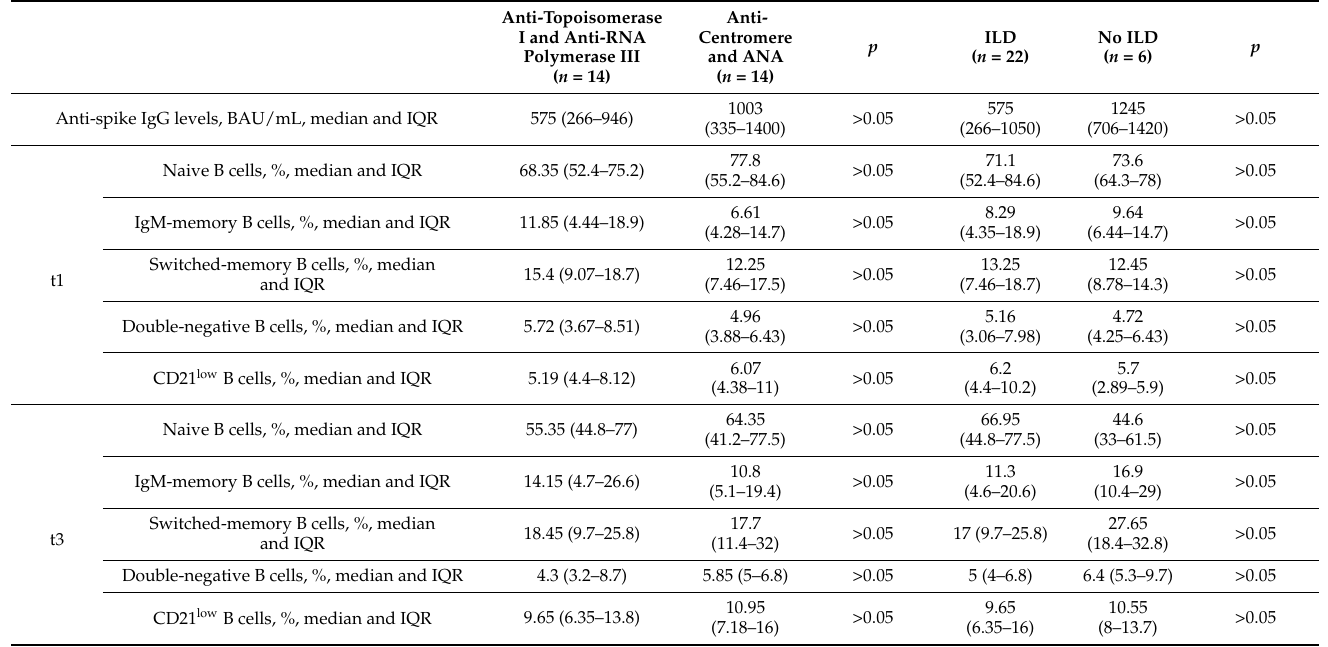
Table 4. B-cell subset distribution at t1 and t3 and serum anti-spike IgG levels in 28 systemic sclerosis (SSc) patients stratified according to antibody positivity and interstitial lung disease (ILD). Anti-Topoisomerase I and Anti-RNA Polymerase III